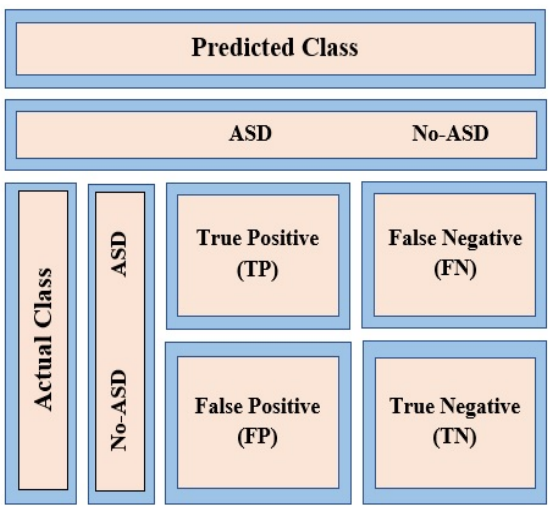
Figure 4. Confusion matrix for autism spectrum disorder (ASD) classification.